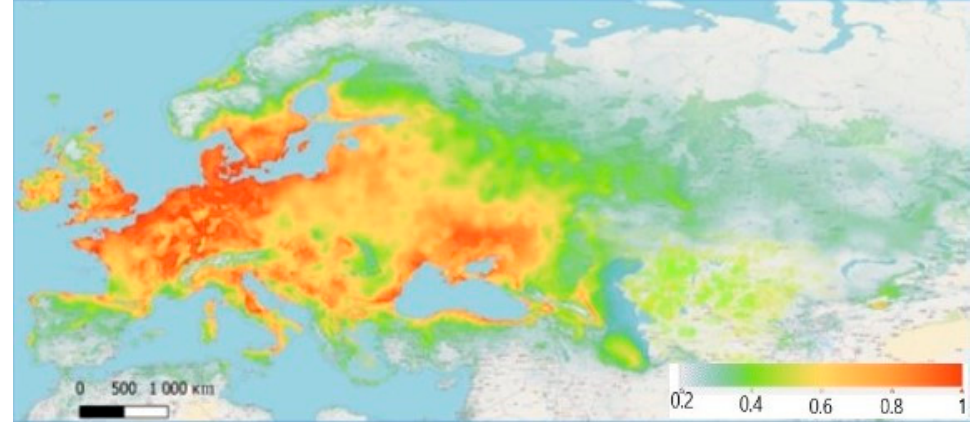
Figure 7. The current bioclimatic range of H. rufipes : the most favourable zones for habitation are red (comfort index –0.80–1.00), close to optimal ranges are orange (comfort index –0.60–0.79), less suitable ranges are yellow (comfort index –0.40–0.59) and unsuitable ranges are light green (comfort index <0.39).